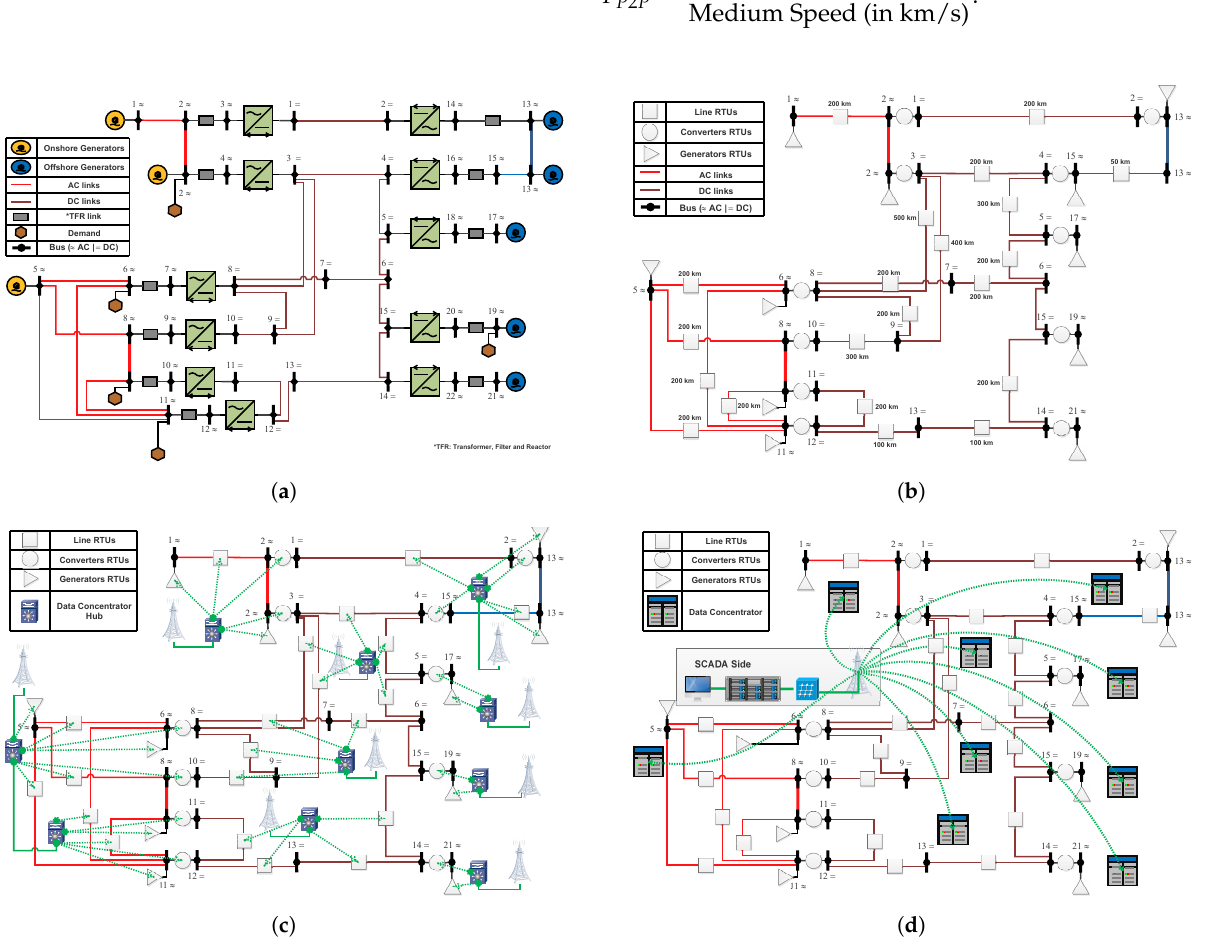
Figure 8. Multi-HVDC/AC transmission systems based on Cigre B4 network test case. ( a ) The Original Network. ( b ) The RTUs distribution. ( c ) The RTUs and data concentrators distribution. ( d ) The SCADA and data concentrators